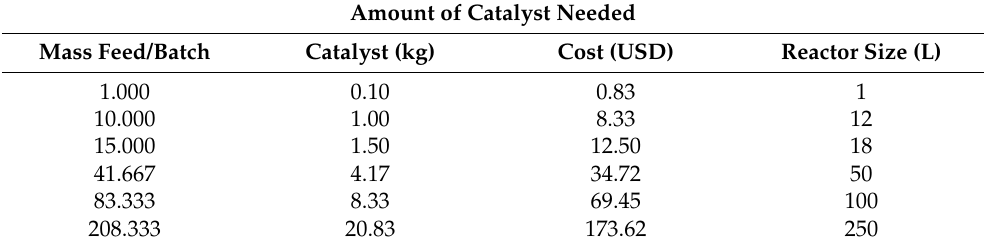
Table 5. Amount of catalyst needed.